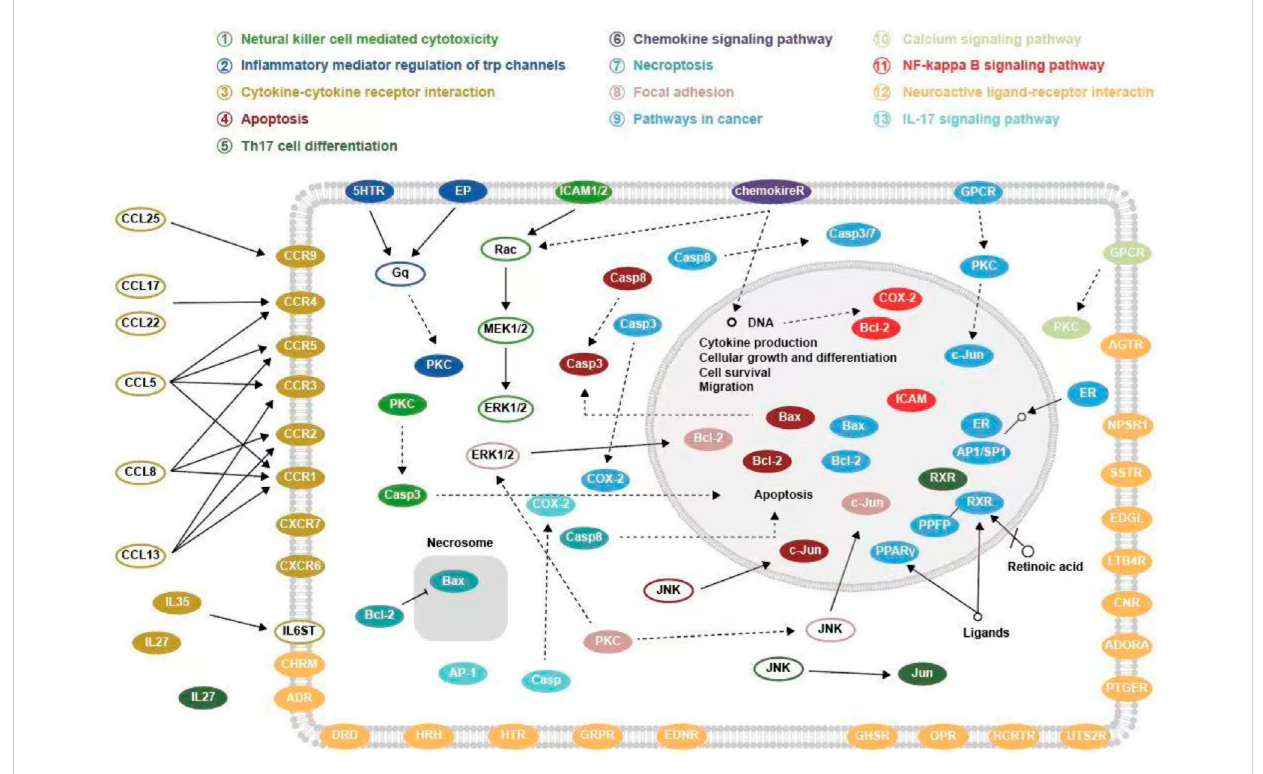
FIGURE 10 Possible targets and signaling pathways for the treatment of RA with SA.